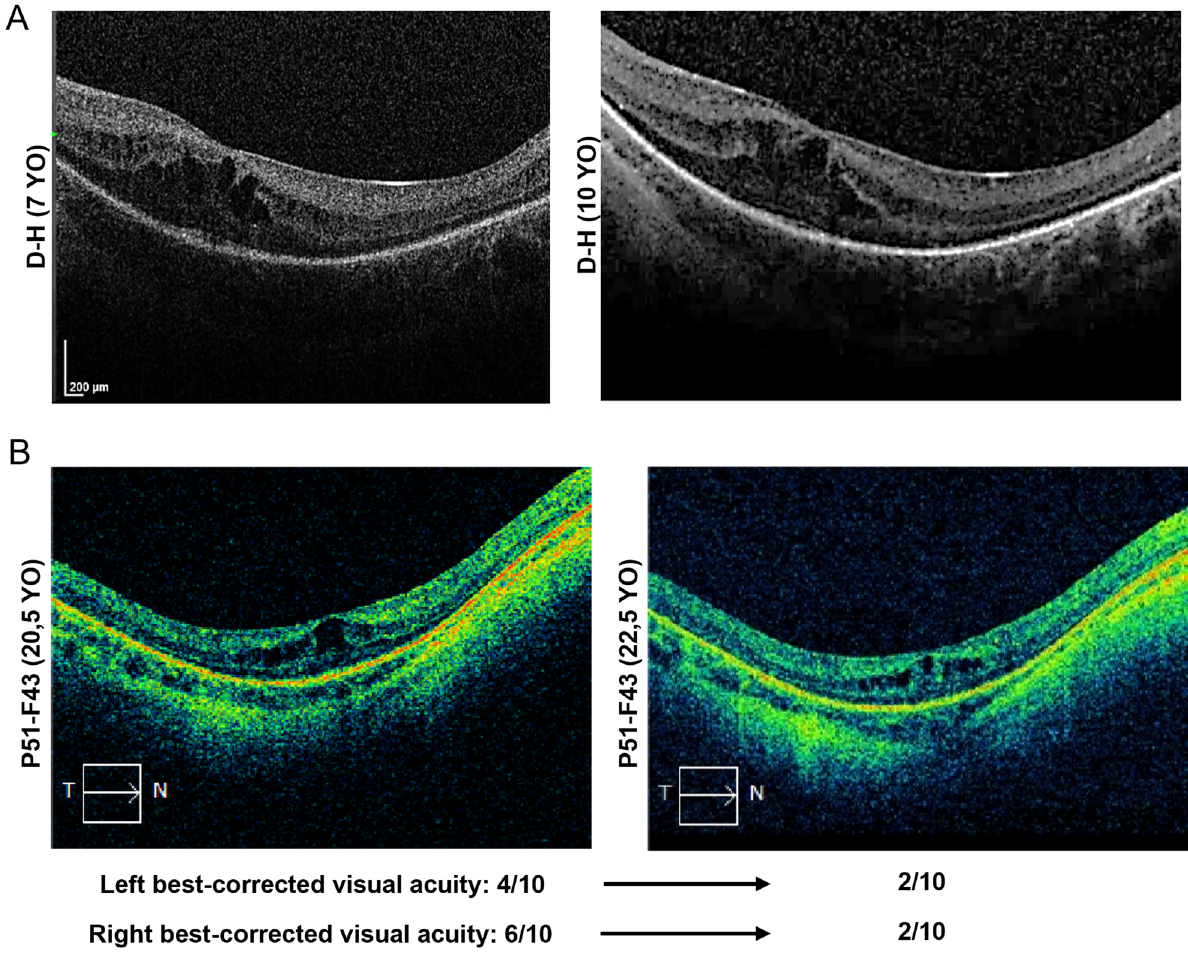
Figure 3. Evolution of CM in absence of treatment. ( A ) In absence of acetazolamide efficacy, patient H–D was left untreated from the age of 6 years until the age of 10 years. Yearly OCT examinations showed little variation in CM manifestations. ( B ) In absence of treatment, patient P51-F43 showed a reduction of CM volume and foveal thickness between the ages of 20.5 and 22.5 years. Conversely, the improvement in CM manifestations was accompanied with a decrease in best-corrected visual